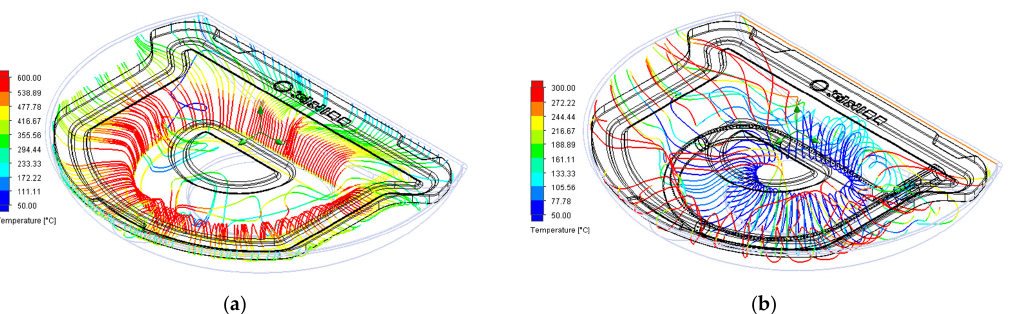
Figure 10. CA#1 combustion system analysis. ( a ) Burner streamline distribution (temperature); ( b ) Air inlet streamline distribution (temperature).